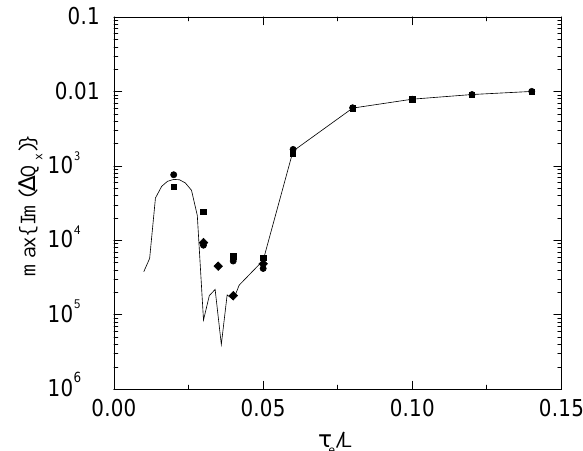
FIG. 7. Im (cid:115) D (cid:81) (cid:120) (cid:100) vs t (cid:101) (cid:121) (cid:76) with physical parameters m (cid:173) (cid:49) , D (cid:81) (cid:115)(cid:99) (cid:173) (cid:48)(cid:46)(cid:50) , (cid:81) (cid:115) (cid:173) (cid:48)(cid:46)(cid:48)(cid:49) , (cid:81) (cid:120) (cid:173) (cid:50)(cid:46)(cid:57)(cid:50)(cid:53) , (cid:87) (cid:48) (cid:173) (cid:50) . The numerical parameters are (cid:110) (cid:44) (cid:173) (cid:50)(cid:53) , (cid:77) (cid:173) (cid:49)(cid:50) , circles; (cid:110) (cid:44) (cid:173) (cid:50)(cid:53) , (cid:77) (cid:173) (cid:50)(cid:52) , squares; (cid:110) (cid:44) (cid:173) (cid:53)(cid:48) , (cid:77) (cid:173) (cid:50)(cid:52) , solid line; (cid:110) (cid:44) (cid:173) (cid:49)(cid:48)(cid:48) , (cid:77) (cid:173) (cid:50)(cid:52) , diamonds.